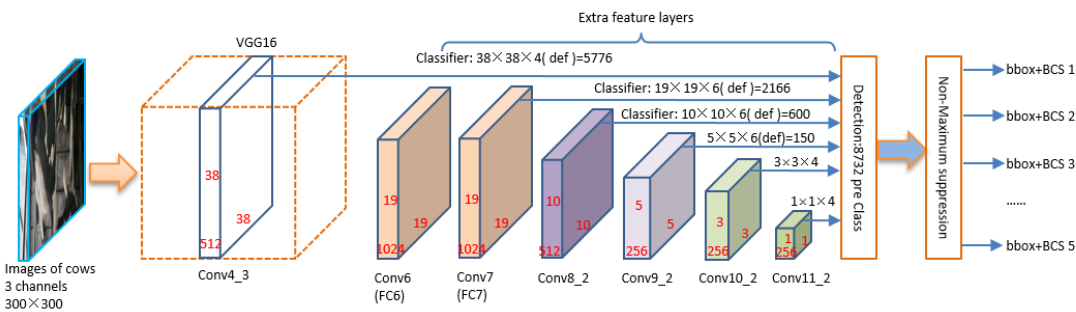
Figure 5. The structure of original Sing Shot multi-box Detector (SSD) method used for BCS assessing.